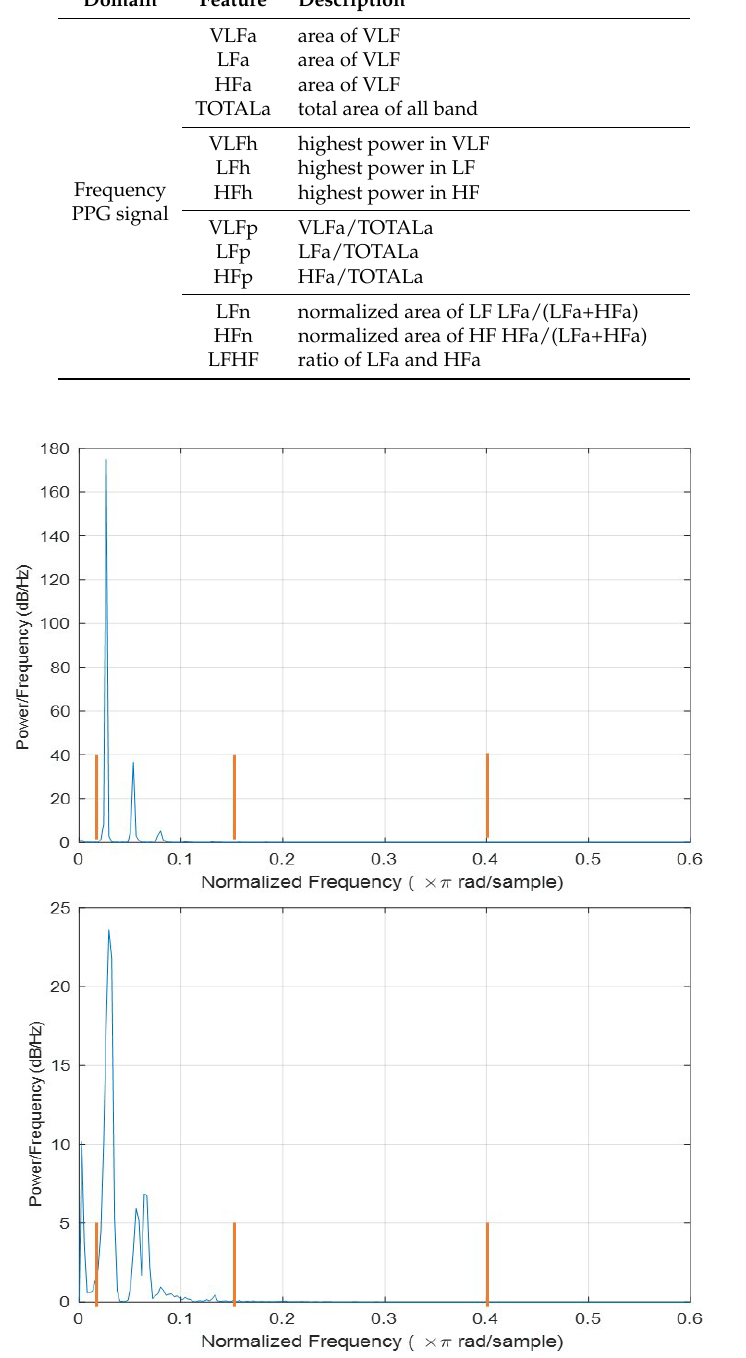
Figure 6. PSD obtained from the PPG signal for high valence and low